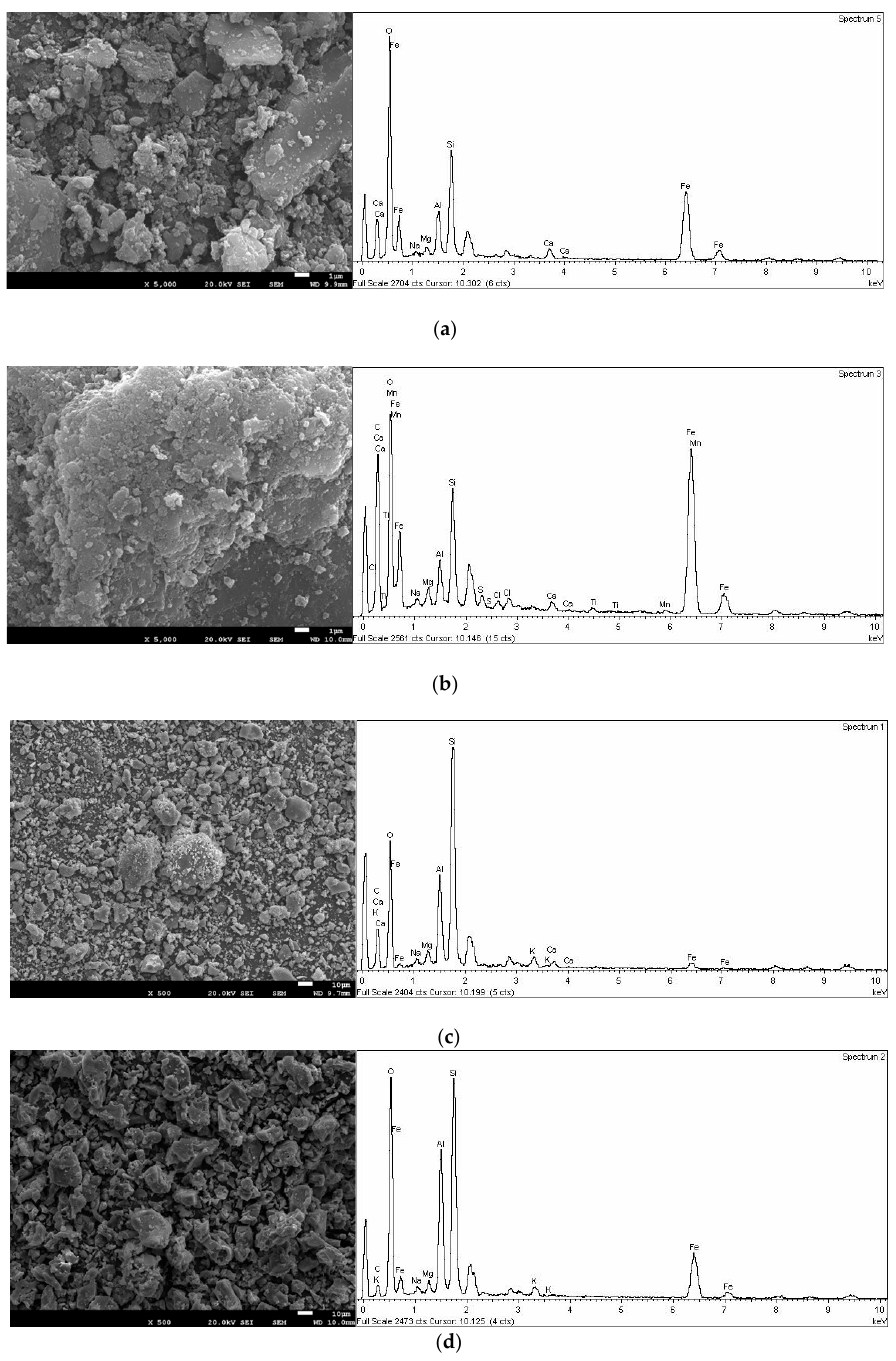
Figure 4. FSEM—EDX of the adsorbents: ( a ) raw muscovite MC, ( b ) iron/manganese muscovite/sodalite LMC, ( c ) monolith muscovite/analcime SLMCT 2 and ( d ) pellets muscovite/analcime composites PLMCT 3 .